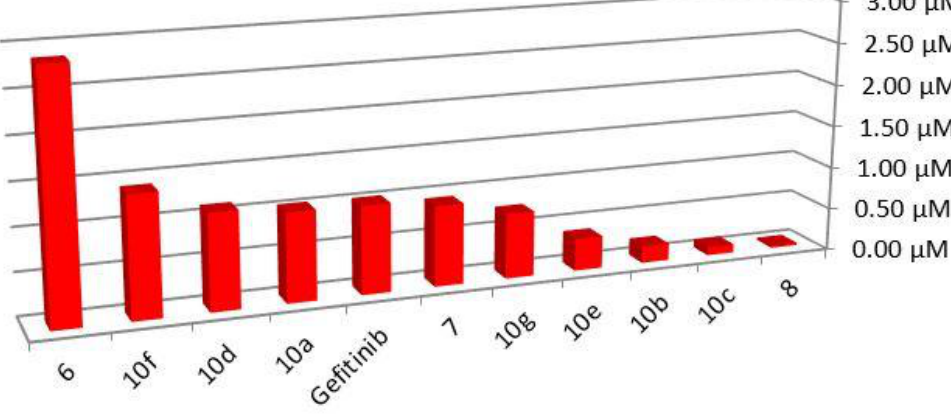
Figure 2. 1/IC 50 values for cytotoxic screening of title compounds against MCF-7 cell line sorted from the least active one ( 8 ) to the most active one ( 6 ). Compounds 6 , 10f , 10d and 10a display better activity than the reference gefitinib.